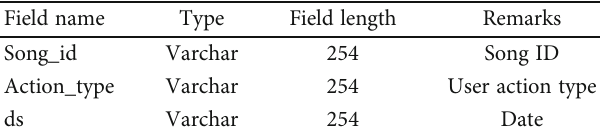
Table 3: Statistics of song click through